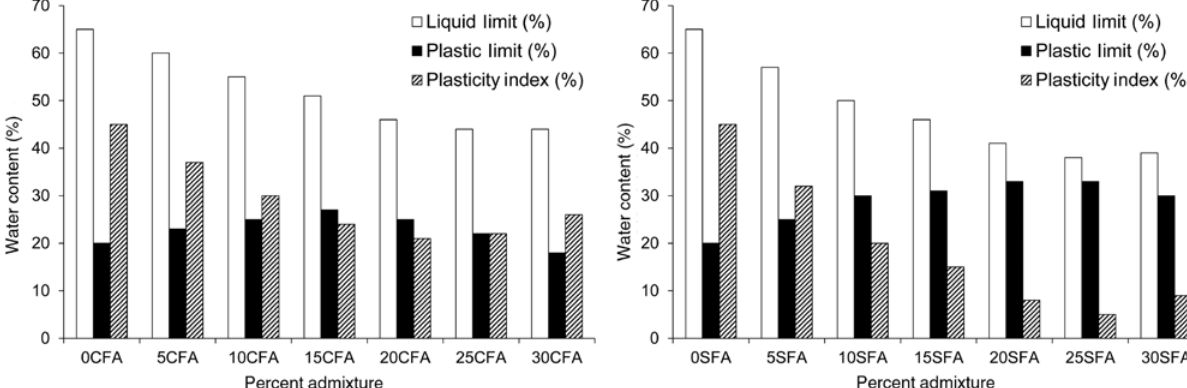
Figure 4: Effect of Catalagzi and Soma fly ash on consistency limits of Soil A.